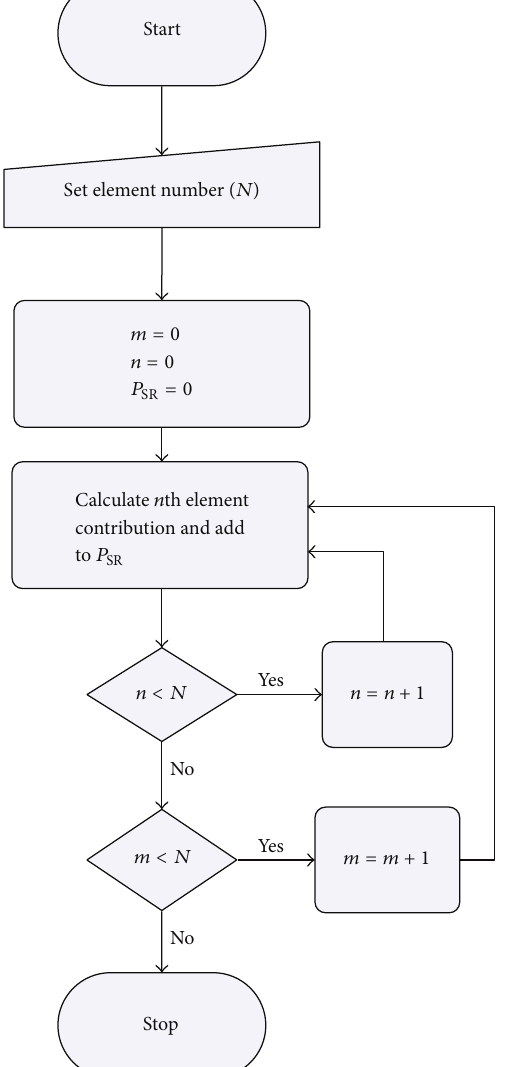
Figure 3: The illustrative flowchart of the SR